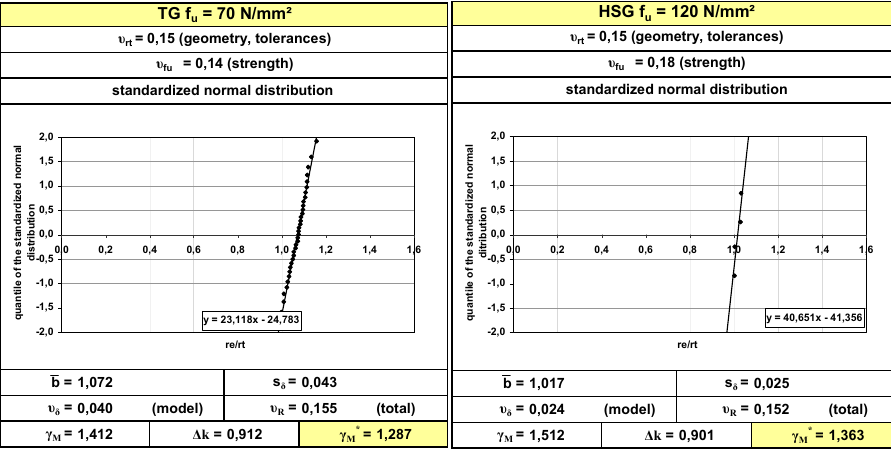
Figure 10: Statistical distribution used for the determination of the partial safety factors for equation (19) considering the imperfection approaches.